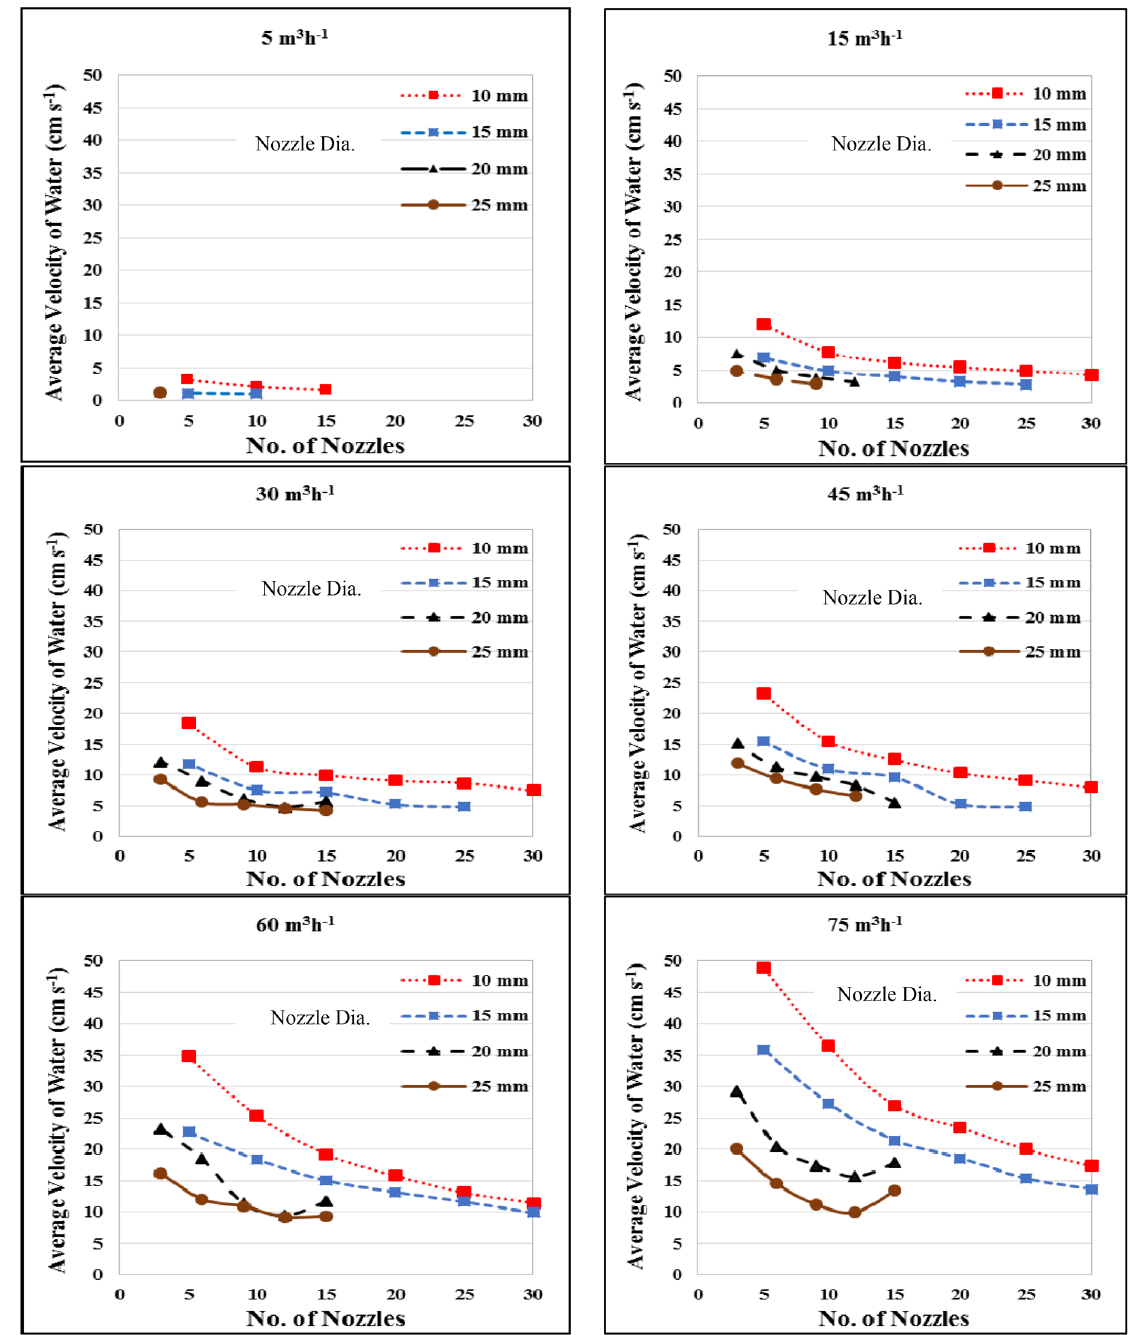
Figure 5. Effect of flow rate, nozzle diameter and number of nozzles on the average velocity of water in a circular